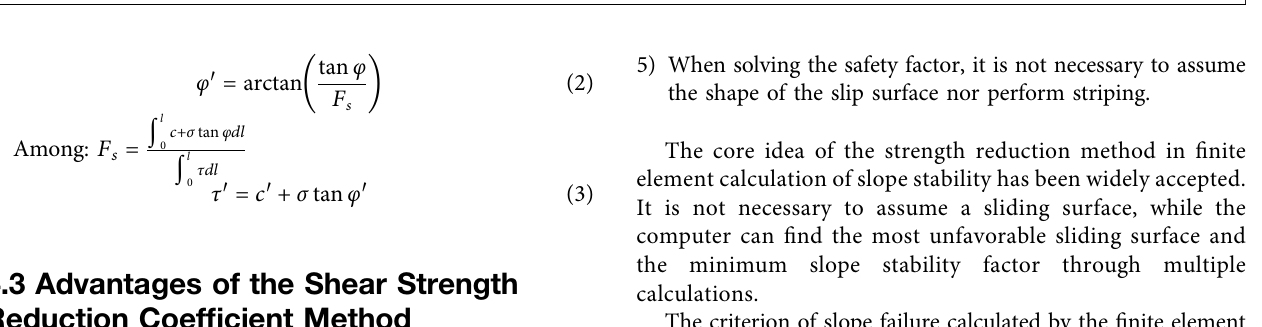
Frontiers in Materials |